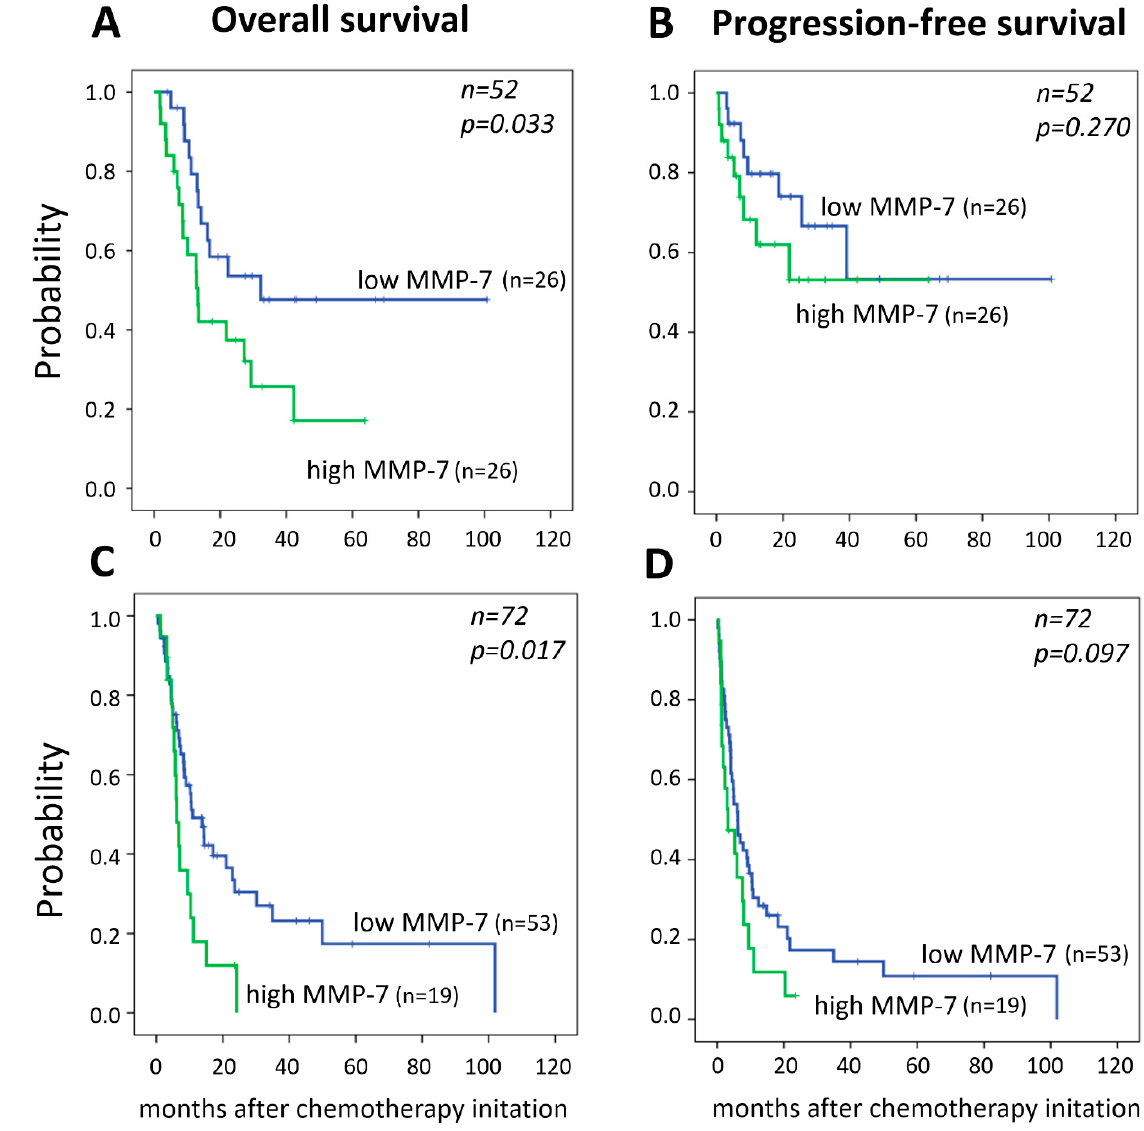
Figure 2. Kaplan–Meier curves of overall and progression-free survival stratified by MMP-7 ( A , B ) serum concentration (>10 ng/mL); ( C , D ) high MMP-7 tissue expression (score > 3). In the IHC cohort, multivariate analysis revealed that patients’ baseline ECOG perfor- mance status and high MMP-7 expression were independent risk-factors for OS ( p = 0.002 and p = 0.009, respectively) and PFS ( p = 0.003 and p = 0.049, respectively) (Table 4). Sim- ilarly, in the ELISA cohort, high pretreatment MMP-7 serum levels were independently associated with shorter OS ( p = 0.011). In addition, the presence of visceral metastases was an independent risk factor for PFS ( p =